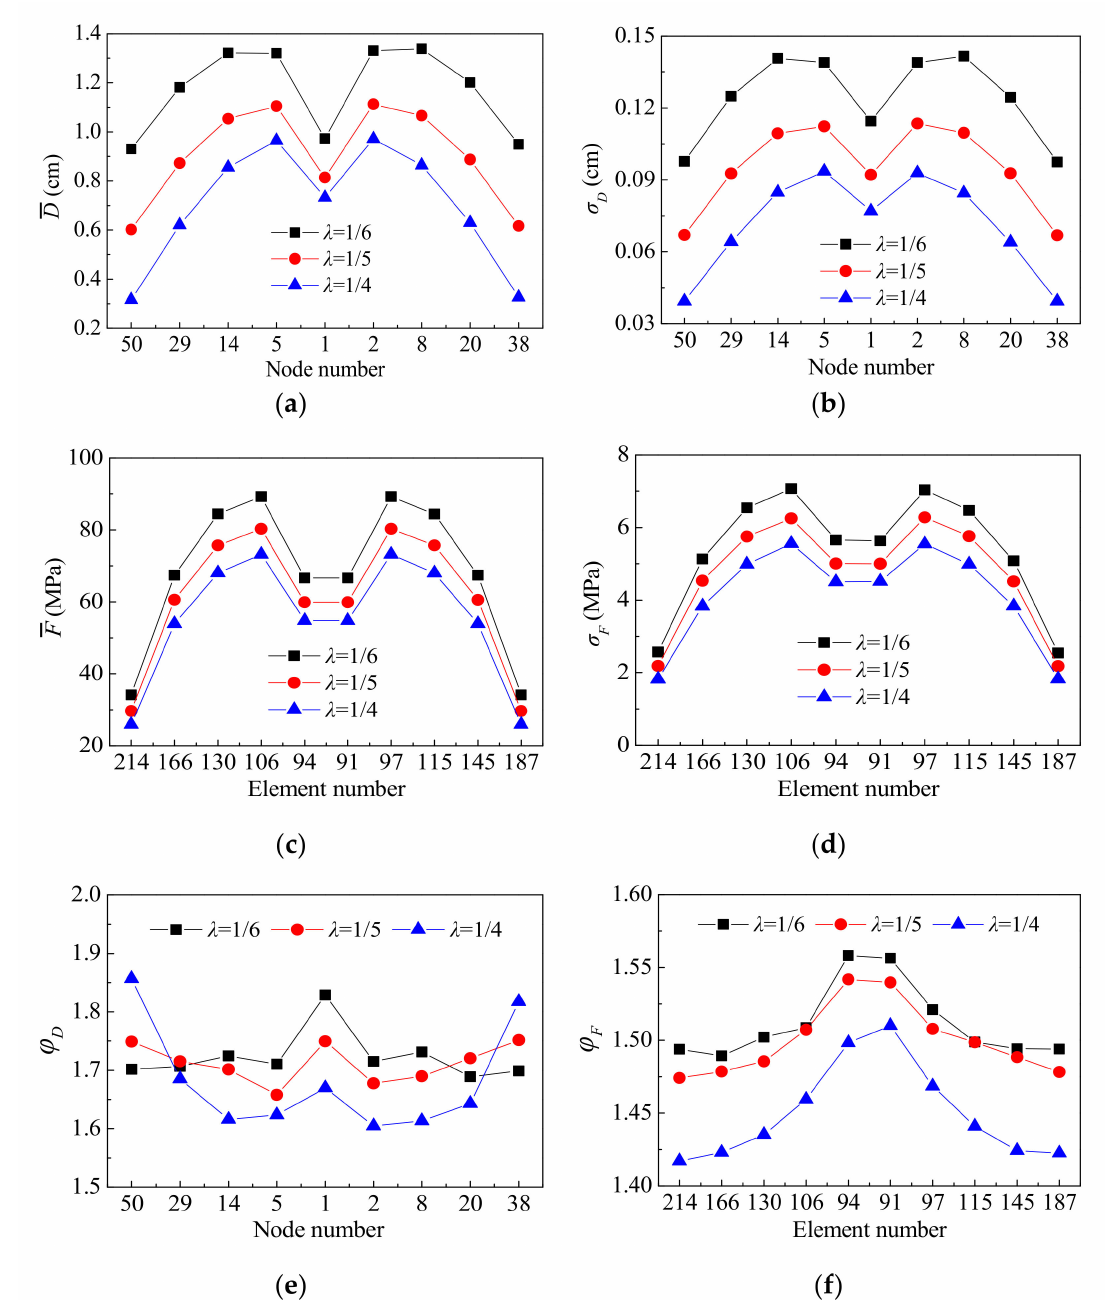
Figure 5. Structural responses versus different rise–span ratios: ( a ) mean displacements of nodes; ( b ) mean square displacements of nodes; ( c ) mean internal forces of elements; ( d ) mean square internal forces of elements; ( e ) DVCs of nodal displacement; ( f ) DVCs of elemental internal